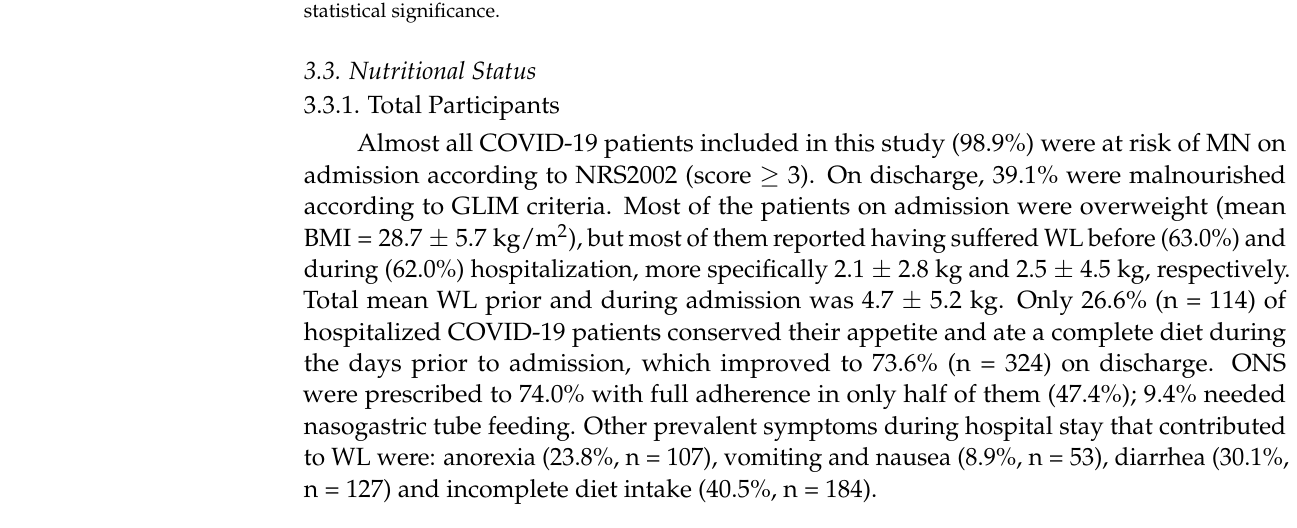
Table 1. Demographic characteristics of the first three waves of COVID-19